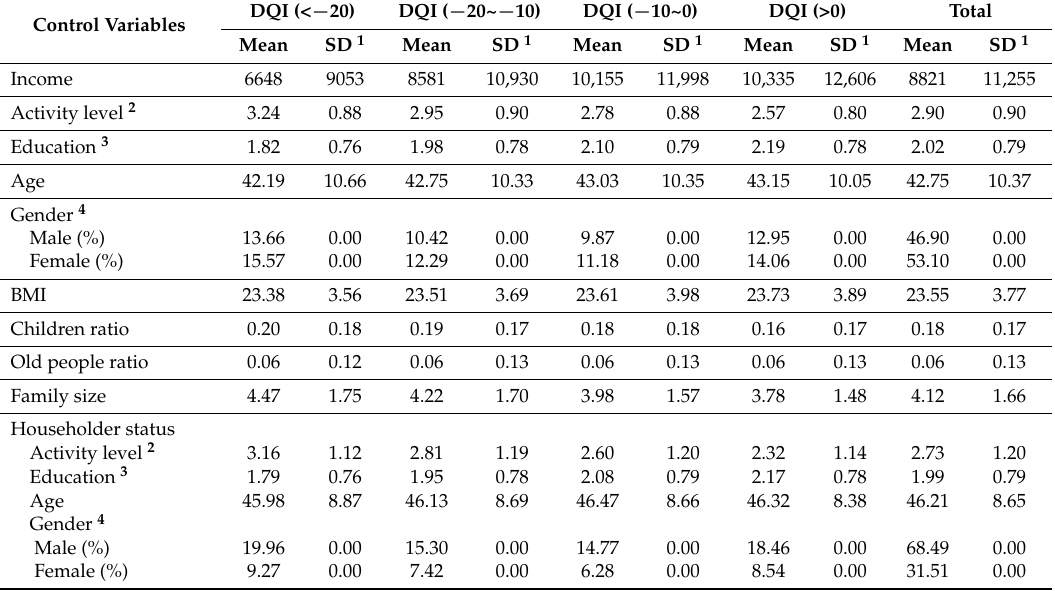
Table 1. Descriptive characteristics of control